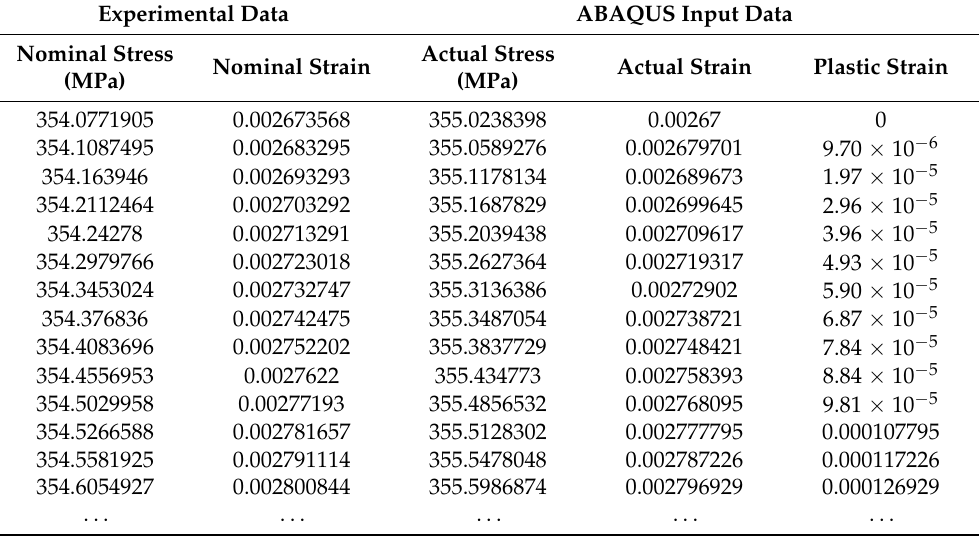
Table 1. Experimental data and input parameters for ABAQUS plasticity